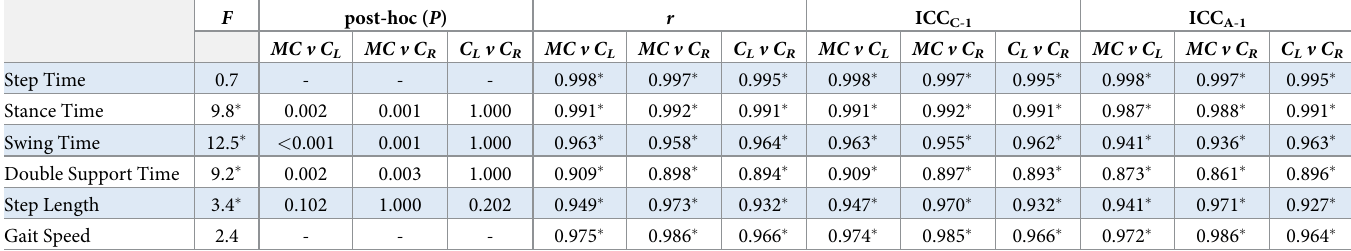
Table 5. Statistical tests for gait parameters calculated as individual participant means. MC : motion capture; C L : OpenPose left-side view; C R : OpenPose right-side view. Asterisks ( � ) denote P < 0.05.